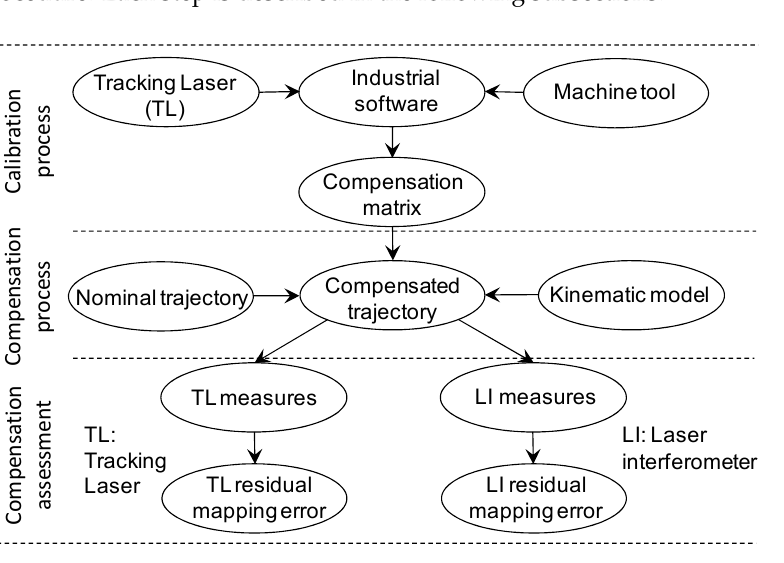
Figure 5. Residual error maps estimation.